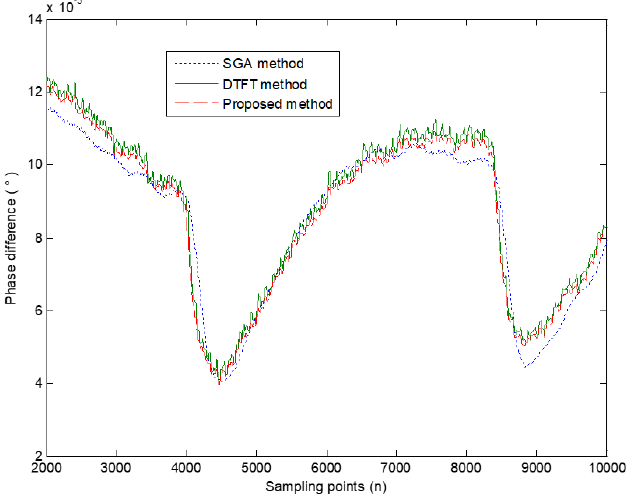
Figure 6. Estimation of phase difference at low flowrate.